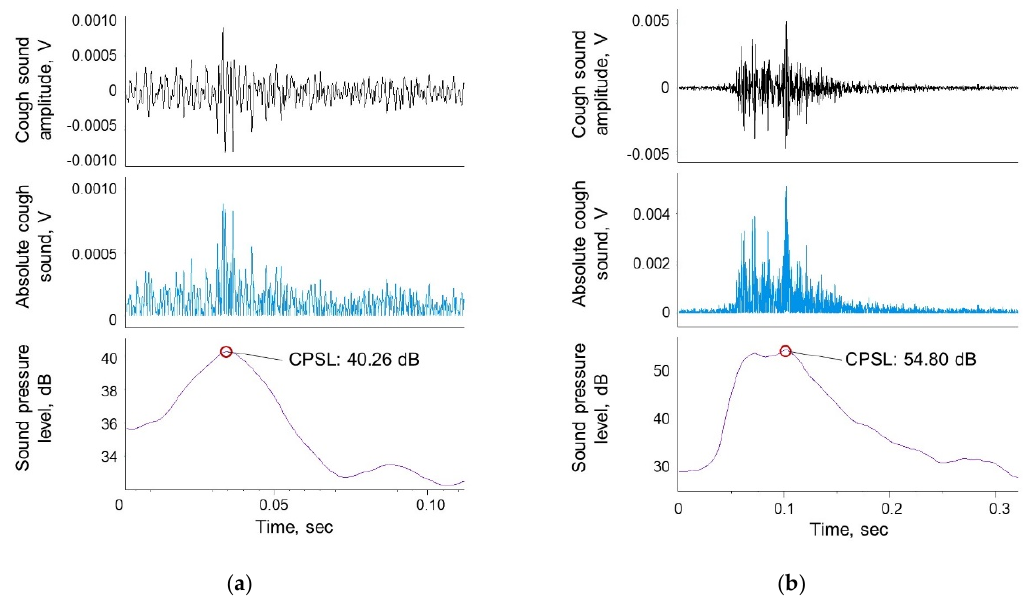
Figure 7. Changes in unassisted and volume-assisted cough sounds in a 20-year-old man with spinal muscular atrophy. The patient used nasal noninvasive positive-pressure ventilation at night. His VC and maximum insufflation capacity (MIC) values were 450 mL and 1050 mL, respectively. The volume-assisted CPF was defined as CPF generated from maximum insufflation by air stacking. The volume-assisted CPS was defined similarly. The unassisted and volume-assisted CPF values were measured by an Access peak flow meter (Philips Respironics, Bend, Oregon, USA). The grey line represents the measured cough sound signal. The solid light blue line represents the bandpass-filtered and rectified sound signal. The solid purple line represents the moving average with a time window of 20 ms. The red circle represents the maximum point of the moving average. ( a ) Unassisted cough sound. The unassisted CPF and CPS values were 80 L/min and 77.8 L/min, respectively. ( b ) Volume-